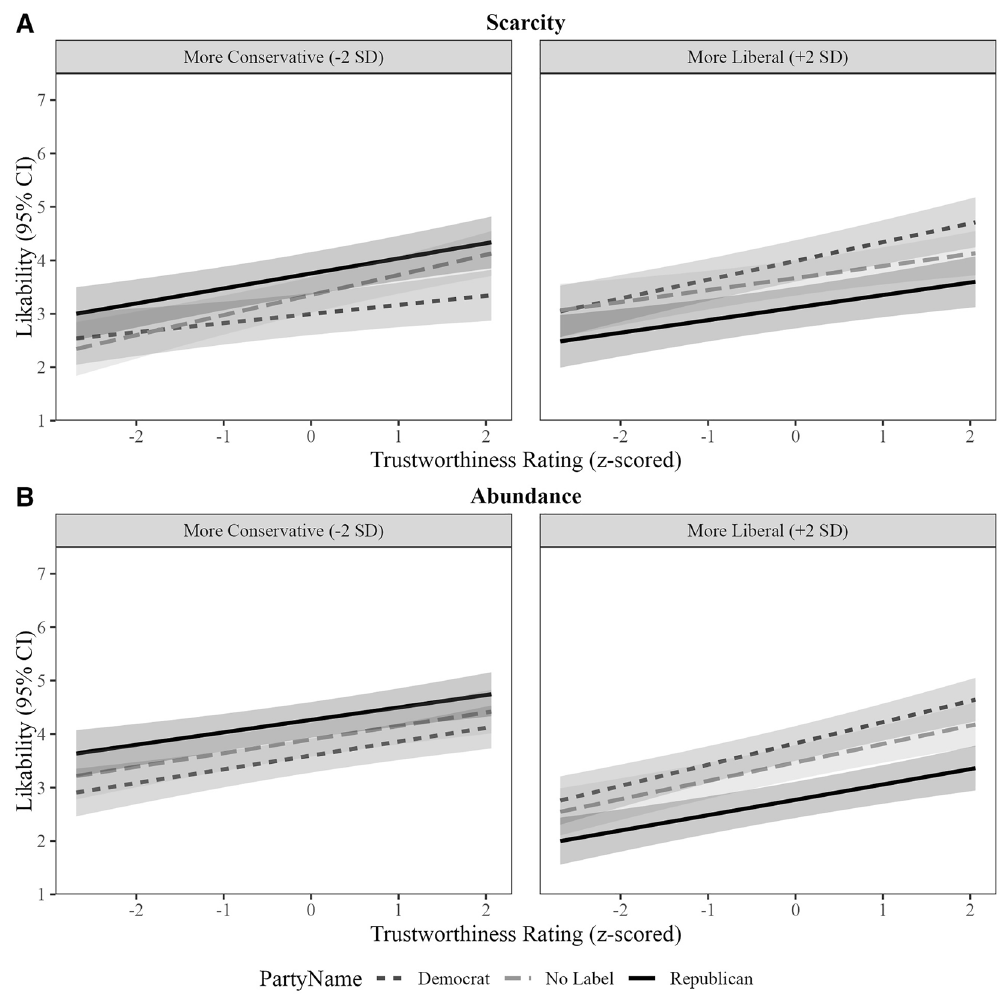
Figure 4. In Experiment 2, perceiver and target partisanship largely interacted to effect facial trustworthiness effects on likability in the scarcity ( A ) but not the abundance ( B ) condition.